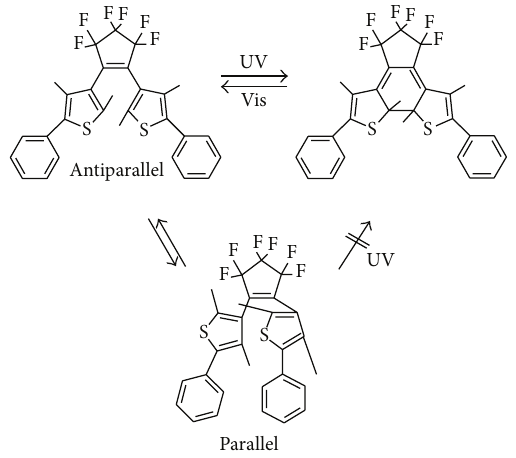
Figure 1: Reaction scheme of